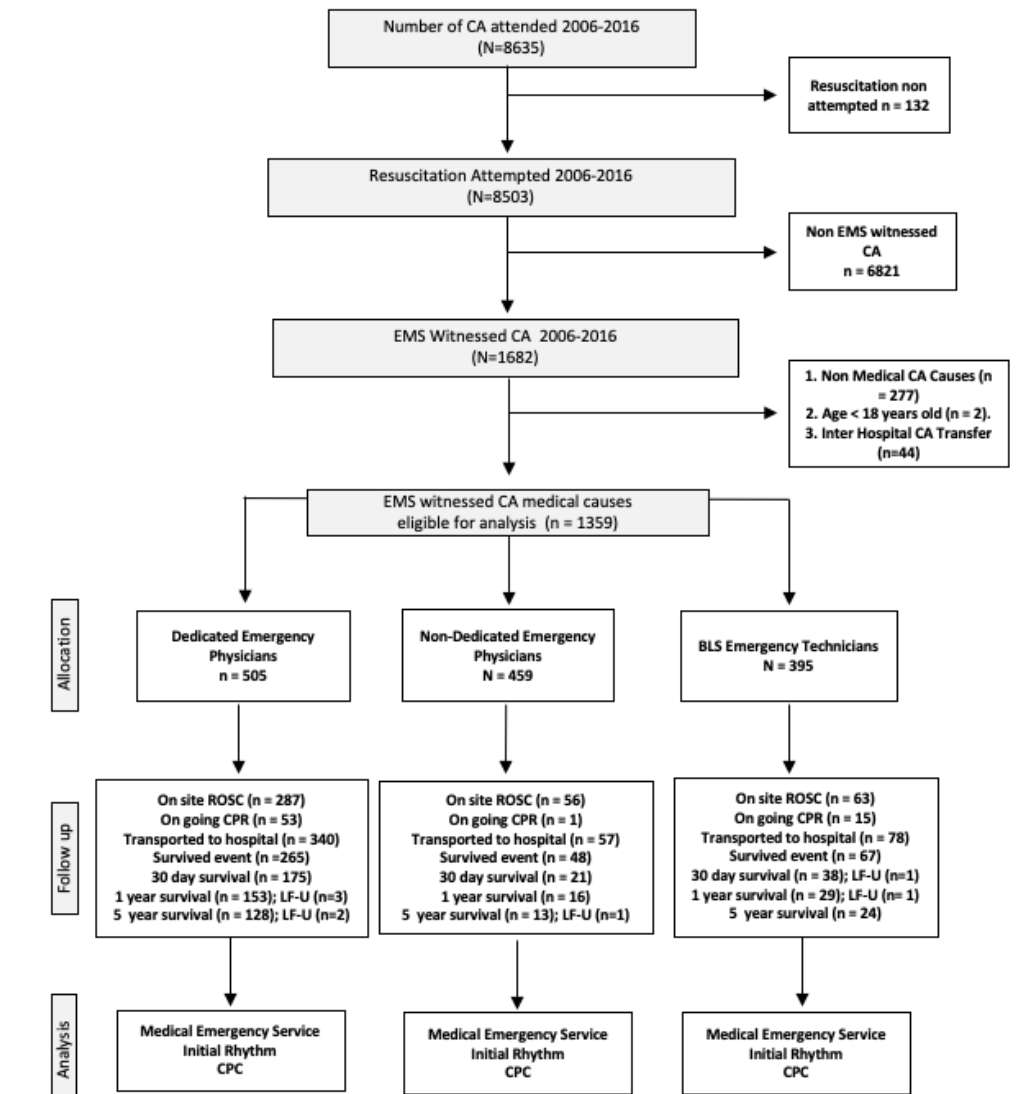
Figure 1. Flowchart. Note: EMS: emergency medical system; CA: cardiac arrest; ROSC: return of spontaneous circulation; CPR: cardiopulmonary resuscitation LF-U: lost to